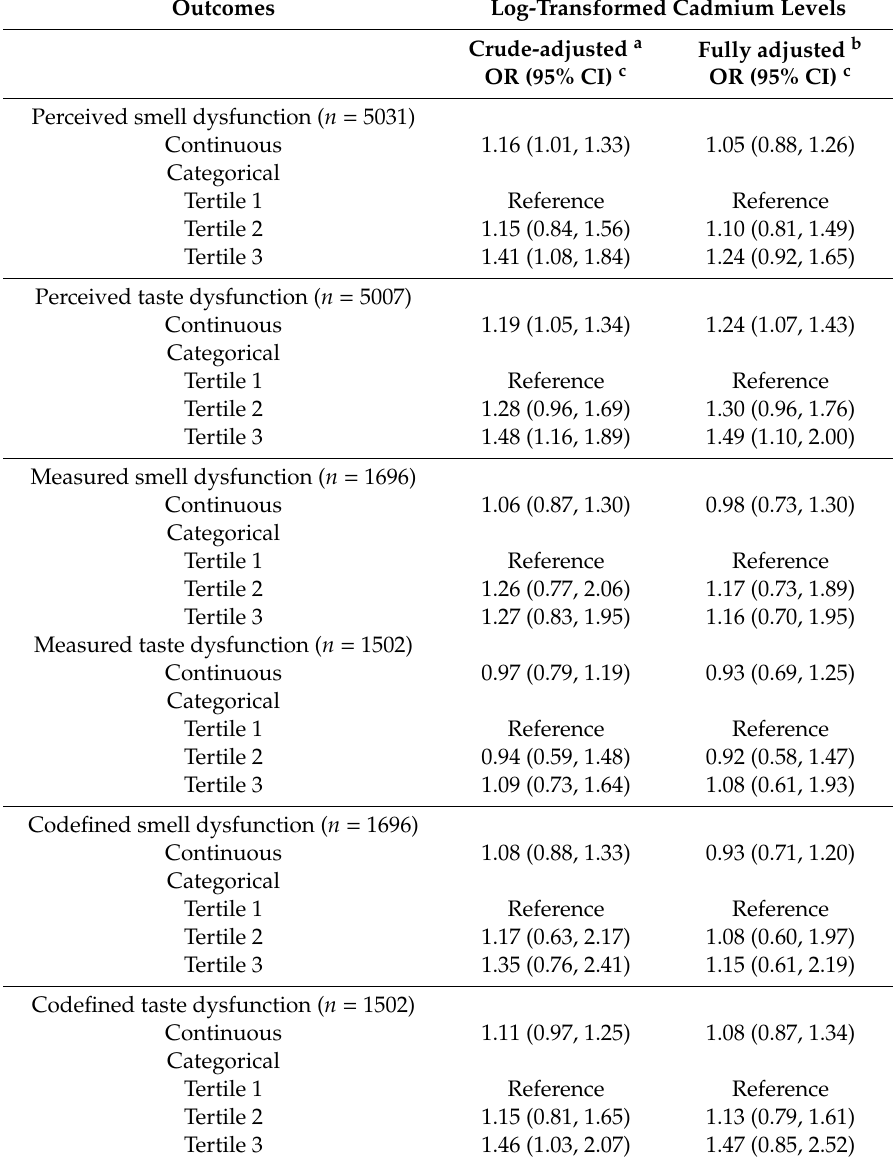
a Crude-adjusted model: adjusting for age, gender, race / ethnicity, education, and income-to-poverty ratio (IPR). b Fully adjusted model: adjusting for age, gender, race / ethnicity, education, IPR, body mass index (BMI), cigarette smoking, and alcohol drinking. c Weighted odds ratio with 95% confidence